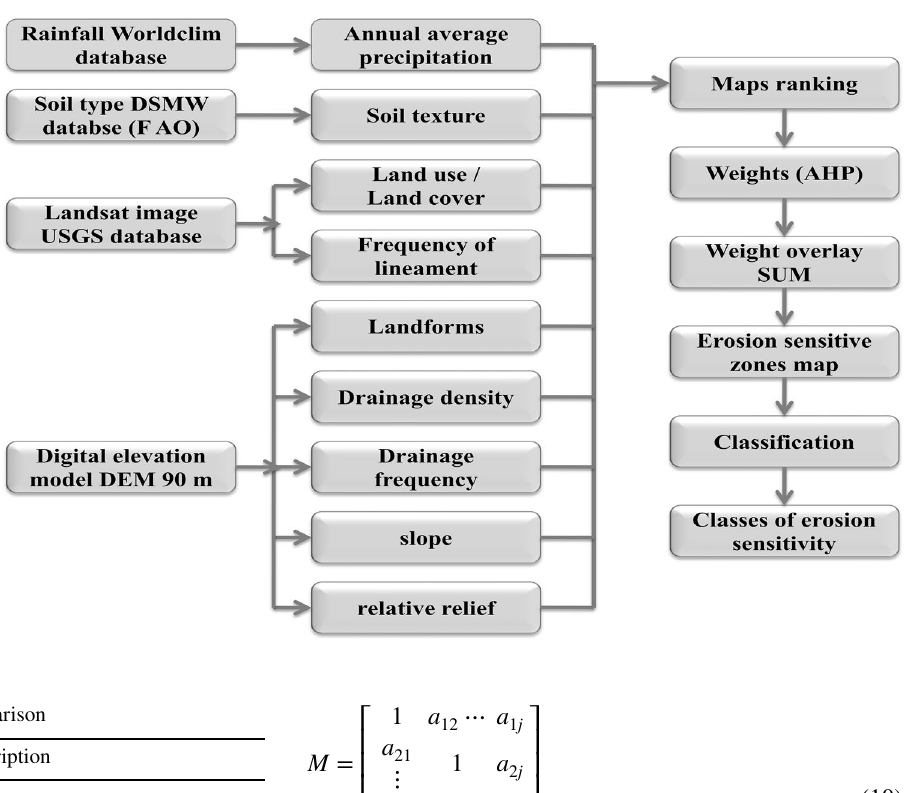
Fig. 6 Soil sensitivity assess- ment (SSEI) methodology for erosion using AHP methods